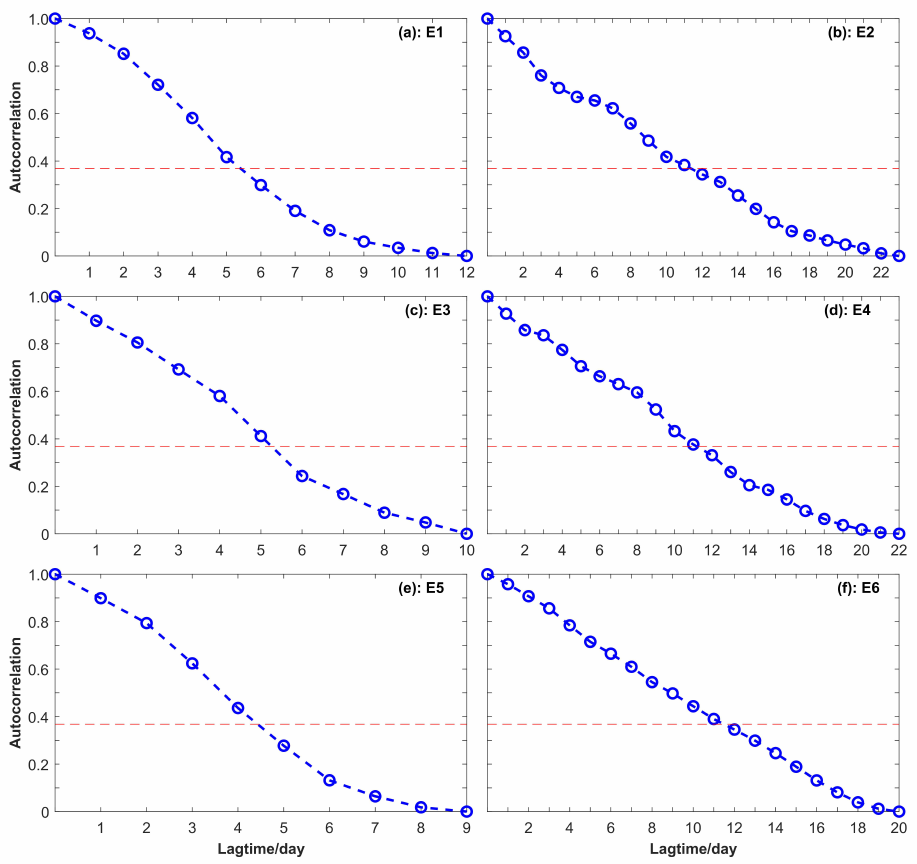
Figure 13. Autocorrelations of the depth-integrated NIKE. Figures ( a – f ) correspond to episodes E1 to E6, and the horizontal red lines denote the value of 1/e.